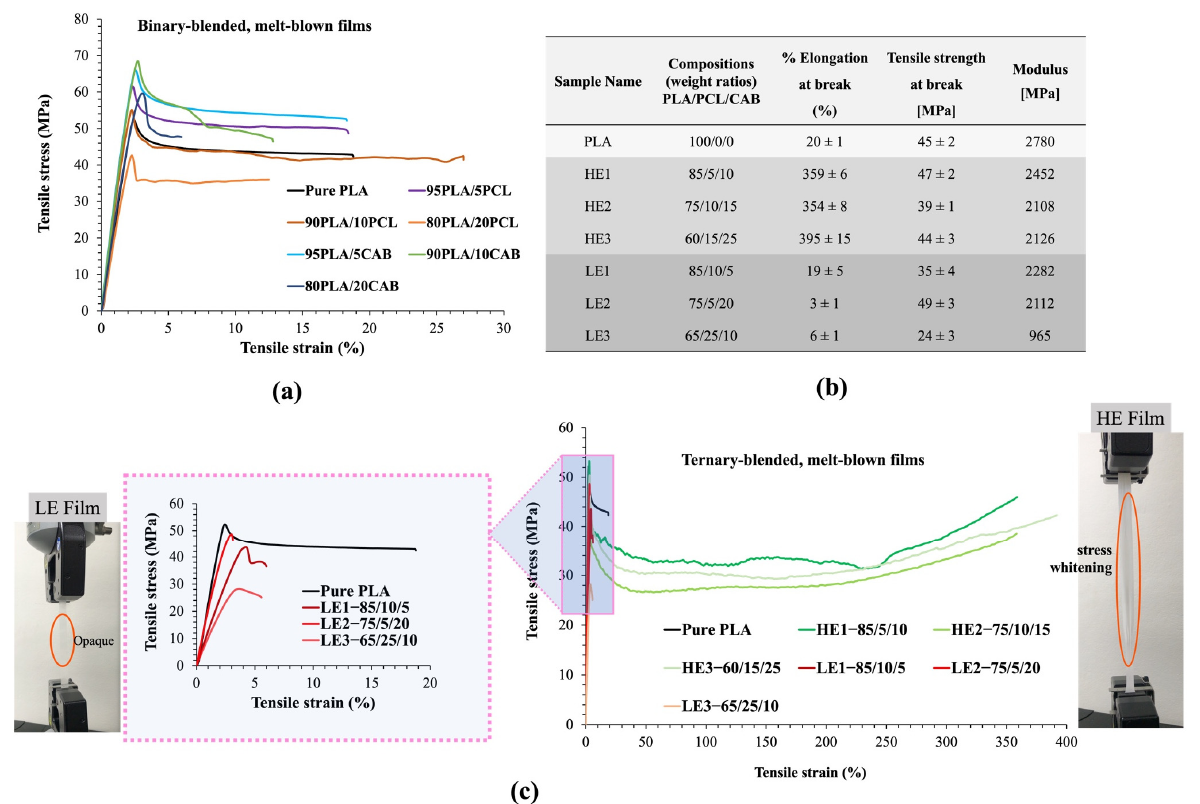
Figure 2. Tensile stress and tensile strain of binary-blended, melt-blown films ( a ), compositions and tensile property of ternary-blended, melt-blown films of LE and HE samples ( b ), tensile stress and tensile strain of ternary-blended, melt-blown films, inset figure shows the low tensile strain of LE film samples and appearances of LE and HE films from the tensile test (load cell of 1 kN and extension rate of 20 mm/min) before break ( c ). Note: Six samples were tested for each blended film.